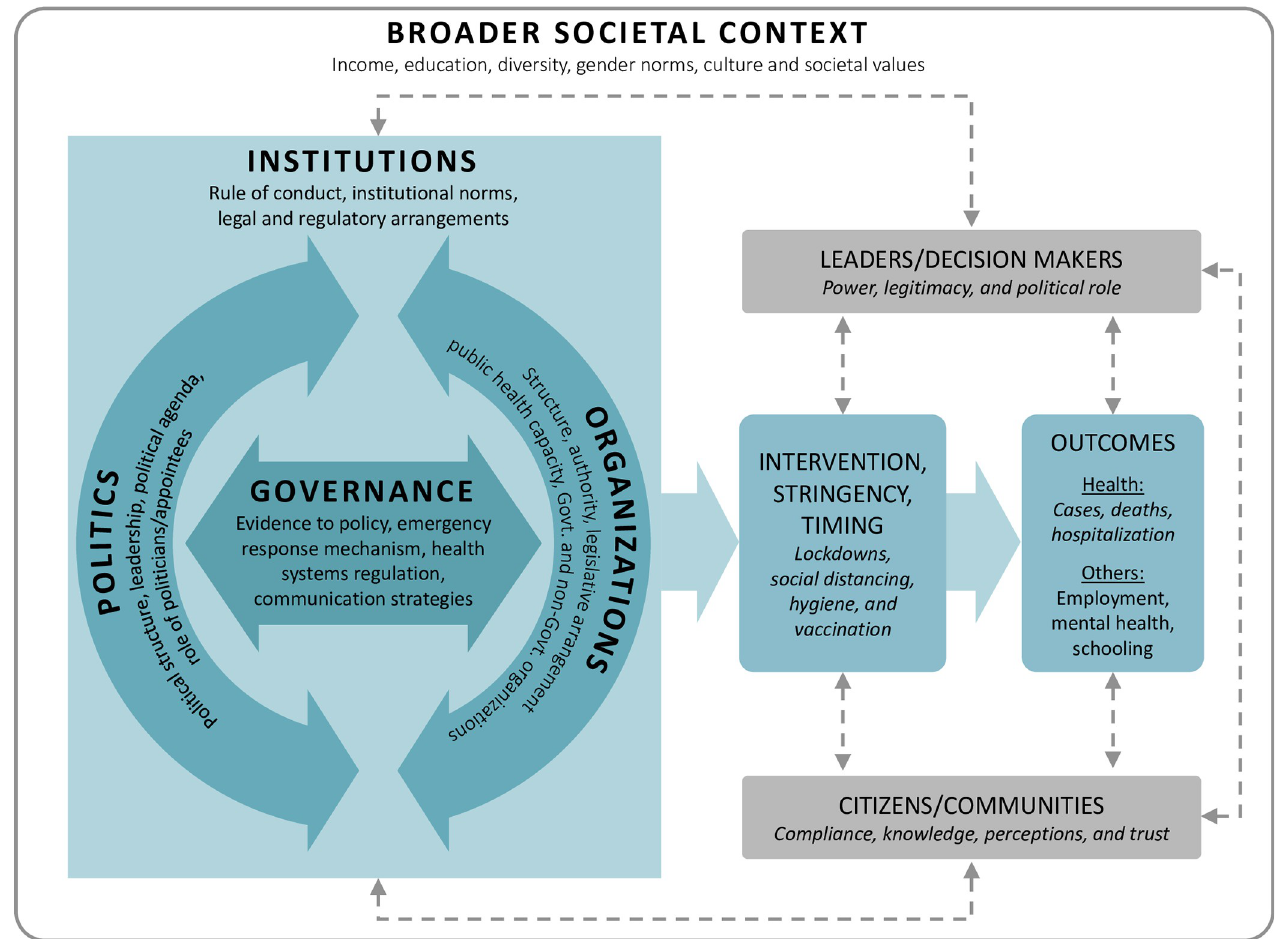
Fig 1. An analytical framework for investigating the impact of institutions, politics, organizations, and governance on the response to COVID-19. (Brubacher LJ, Hasan MZ, Sriram V, et al. Investigating the Influence of Institutions, Politics, Organizations, and Governance on the COVID-19 Response in British Columbia, Canada: a Jurisdictional Case Study